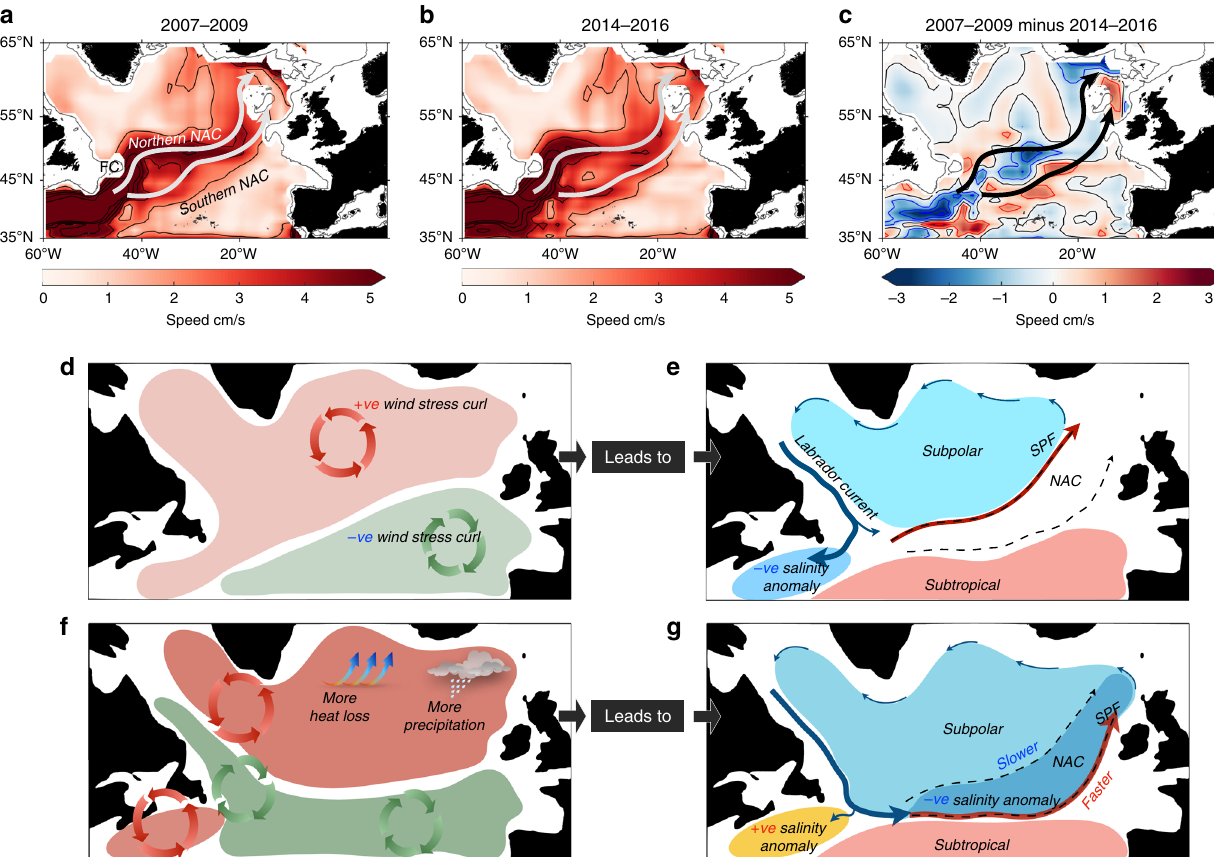
Fig. 10 Changed ocean circulation in response to atmospheric forcing. a – c Geostrophic current speed at 200 m during a mean of 2007 – 2009; b mean of 2014 – 2016; c difference between the two periods [(2014 – 2016) – (2007 – 2009)]. Speed calculated from geostrophic velocity at 200 m computed from EN4 data, with zero reference velocity at 1200 m. d – g schematic summary of atmospheric and oceanic processes that impact the salinity and freshwater content of the subpolar region; d the mean pattern of windstress curl in 2005 – 2009 with positive curl over the subpolar region and negative to the southeast; e the resulting mean ocean circulation with a cyclonic subpolar gyre, the North Atlantic Current (NAC) zone following the zone of zero and low windstress curl, the Subpolar Front (SPF) located in the northern NAC zone, and the Labrador Current follow a primary pathway along the edge of the continental shelf; f wind stress curl pattern in 2014 – 2016, with stronger positive curl over the subpolar North Atlantic associated with increased heat loss and increased net precipitation, and a zone of negative curl over the Labrador and Newfoundland shelf and Newfoundland Basin; g the resulting ocean circulation in 2014 – 2016 with the Labrador Current following a new primary pathway into the NAC zone, the SPF shifted to the south, a slower northern NAC zone and faster southern NAC zone, and the resulting positive salinity anomaly in the North West Atlantic Continental Shelf and Slope region and negative salinity anomaly in the eastern Subpolar